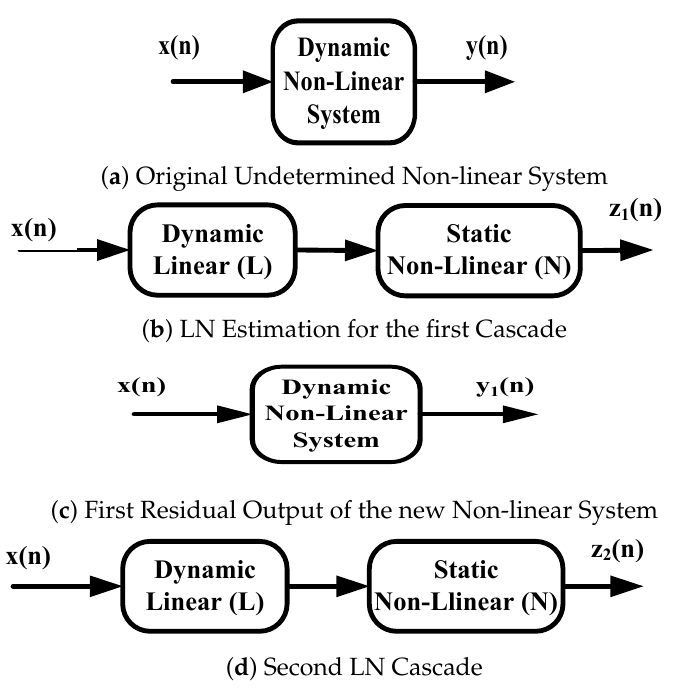
Figure 3. Illustration of the parallel cascade identification.